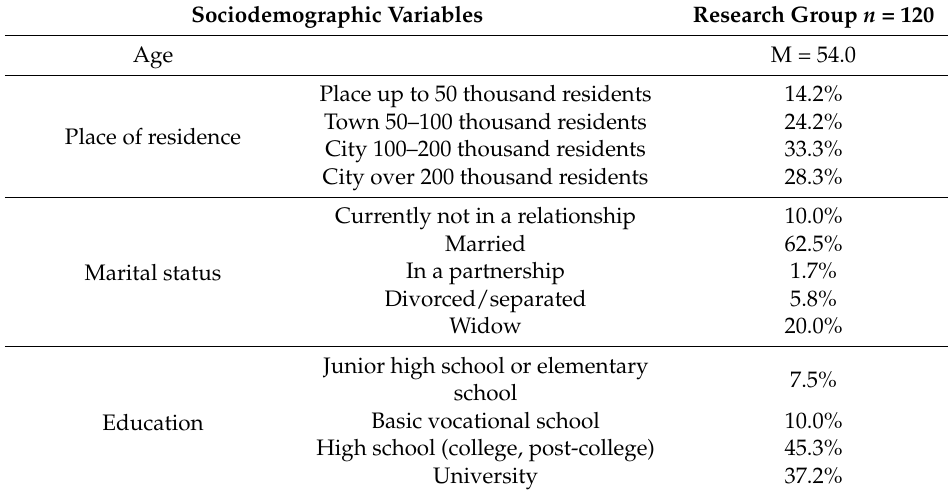
Table 1. The characteristics of women from the clinical group (sociodemographic variables) ( n = 120).